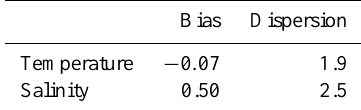
Table 1. RCRV scores for 0–200m layer temperature and salinity; same period and area as in Fig. 4.